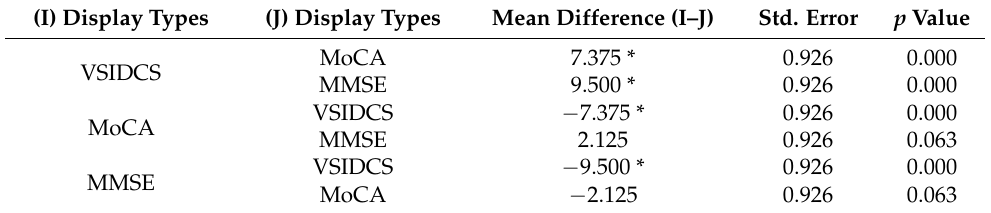
Table 7. Tukey’s post hoc tests for the effects of VSIDCS, MoCA, and MMSE on